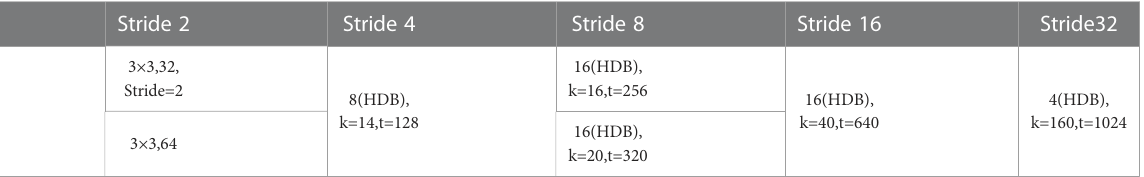
TABLE 1 HarDNet68 parameters.